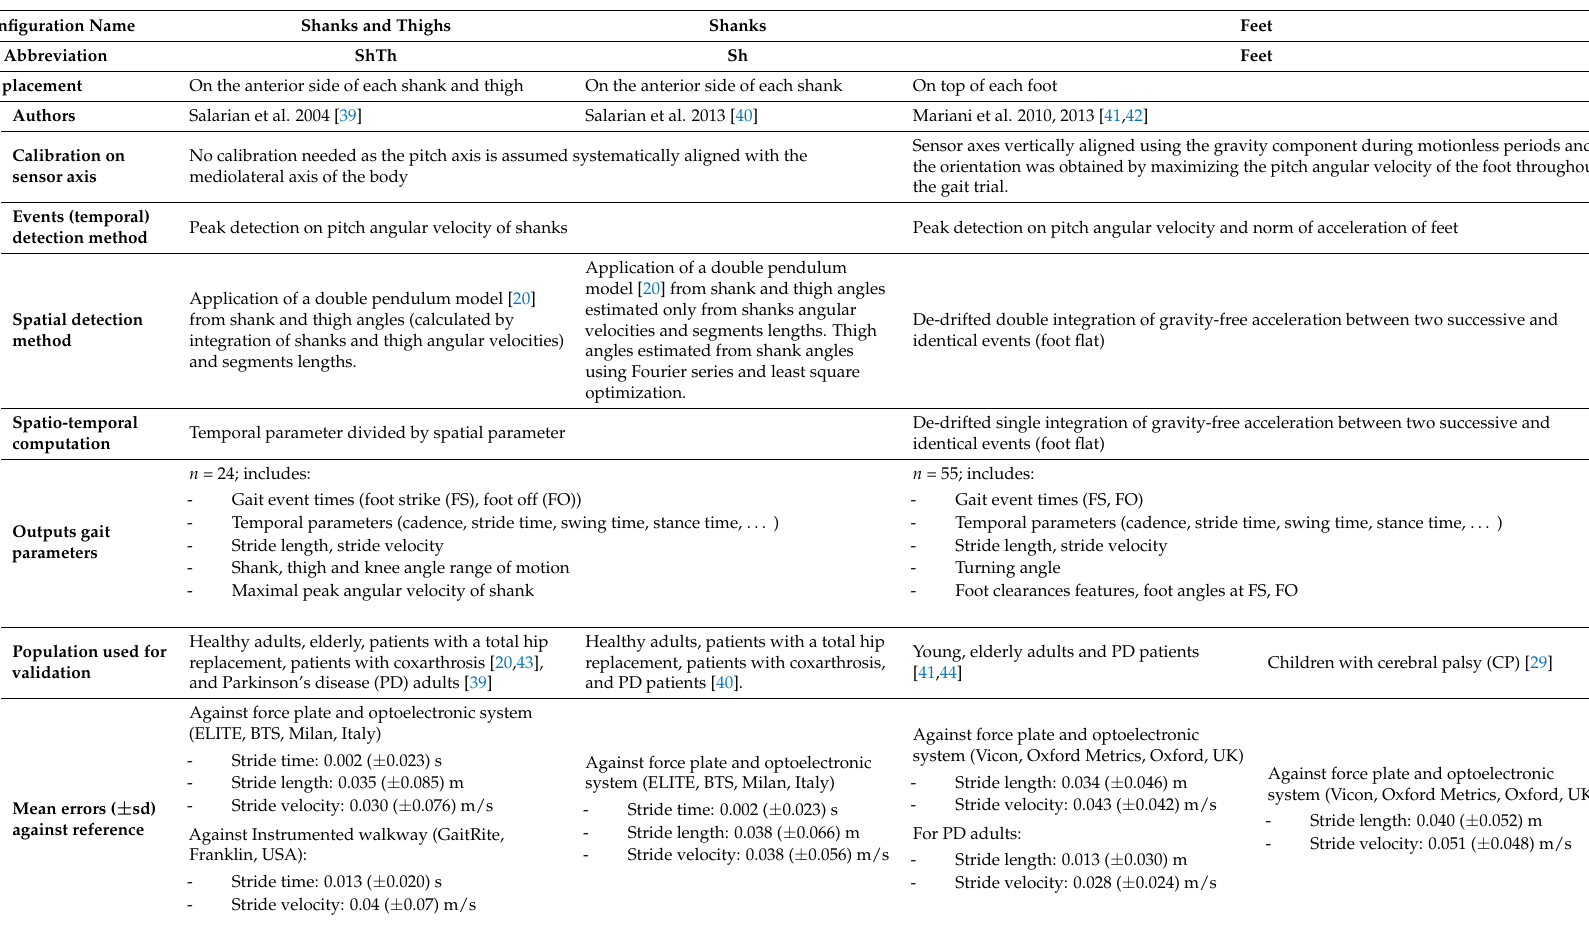
Table 1. Description of the three wearable configurations: ShTh, Sh, and Feet according to the sensors placement and associated